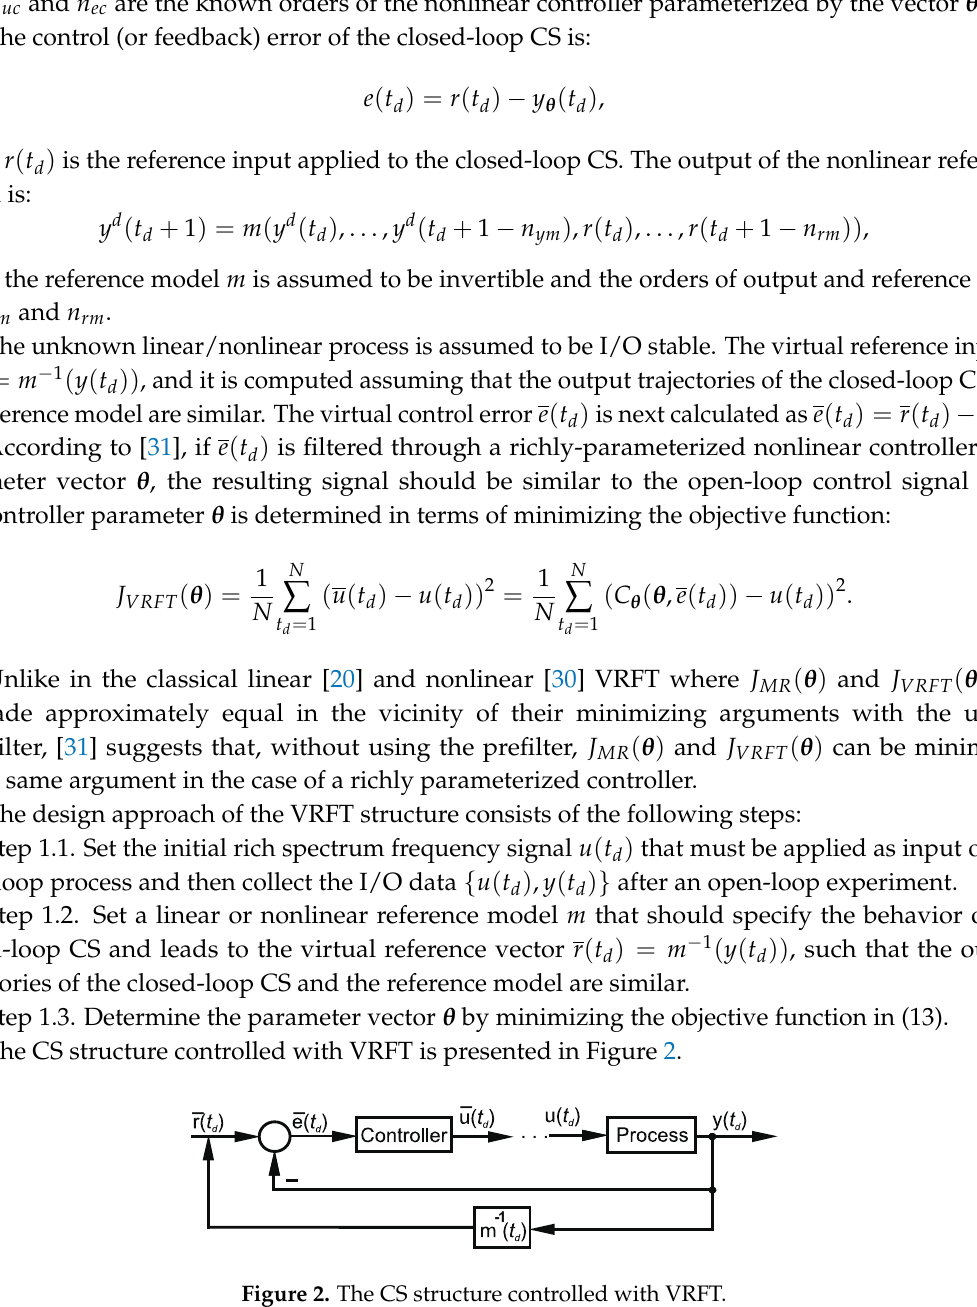
Figure 2. The CS structure controlled with VRFT.